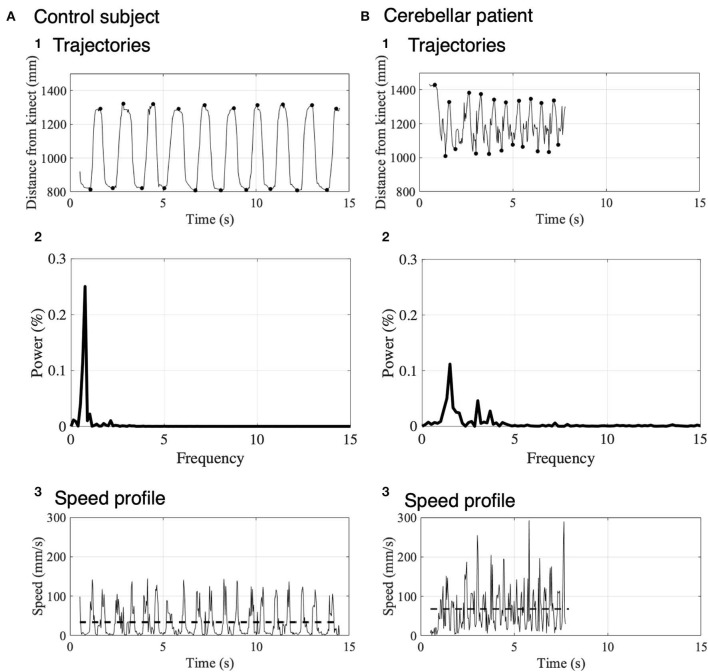
Movement kinematics of IF in the nose-finger test for a control subject (A) and a patient (B). (A1) Trajectory of IF measured as the distance from the Kinect v2 to IF in a control subject. Black dots show the local maxima and local minima of the distance. (A2) Spectrum analysis of trajectories of IF shown in (A1). Note that the power is normalized. (A3) Speed profile represented by the difference of the trajectory in the control subject. The dashed lines indicate the average speeds. (B) Trajectory (B1), Spectrum analysis of trajectories of IF (B2) and velocity profile (B3) in a cerebellar patient. The same conventions as in (A).